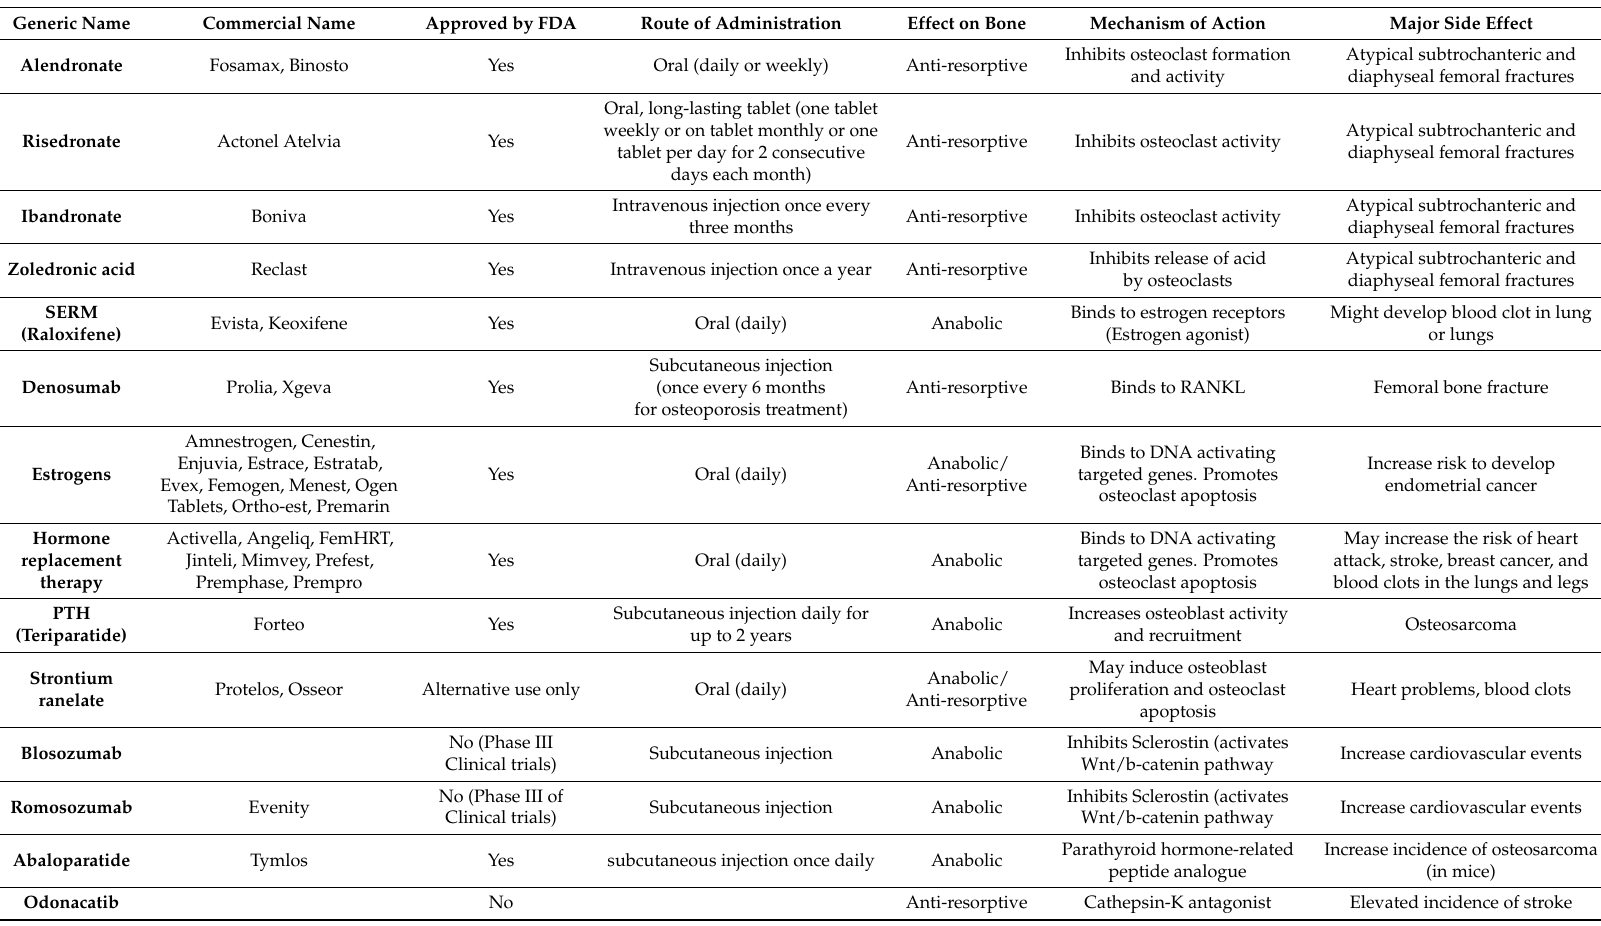
Table 3. Drugs currently available to treat